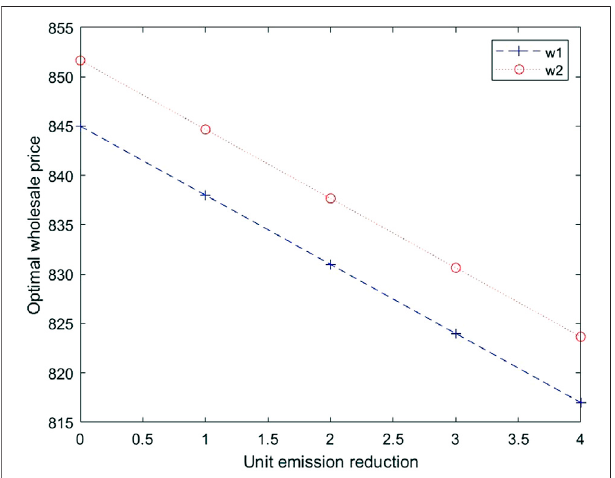
FIGURE 4 | Retailer price comparison chart.